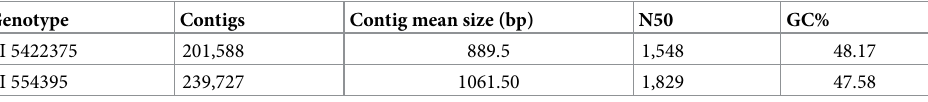
Table 2. Basic statistics of the primary assemblies generated for PI 5422375 and PI 554395 genotypes of Ae . umbellulata .